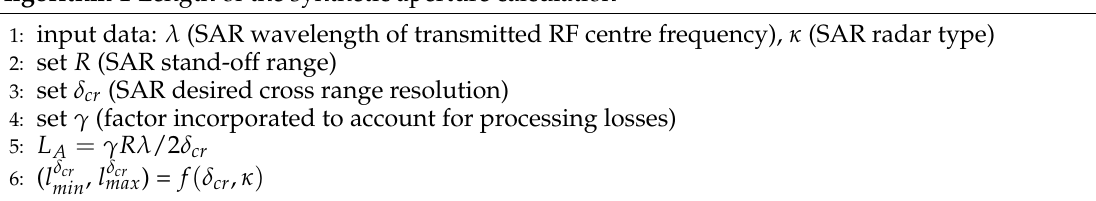
Algorithm 1 Length of the synthetic aperture calculation